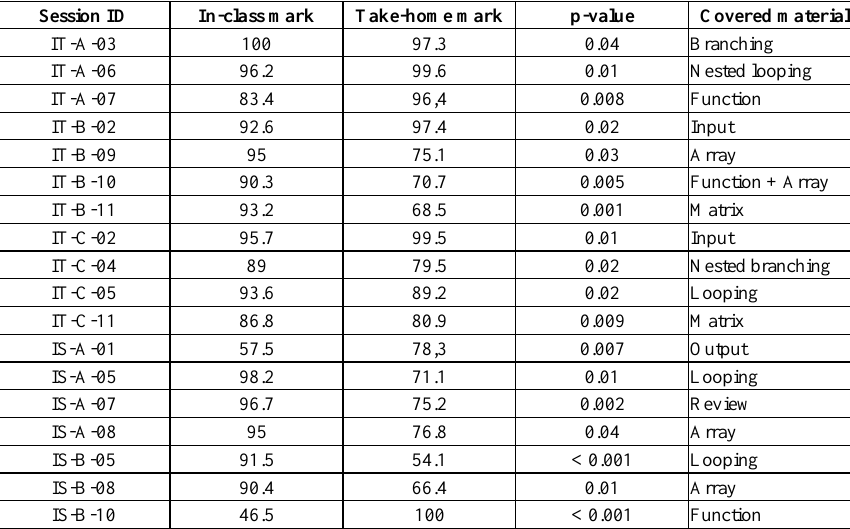
Table 2. Statistically significant change between in-class and take-home